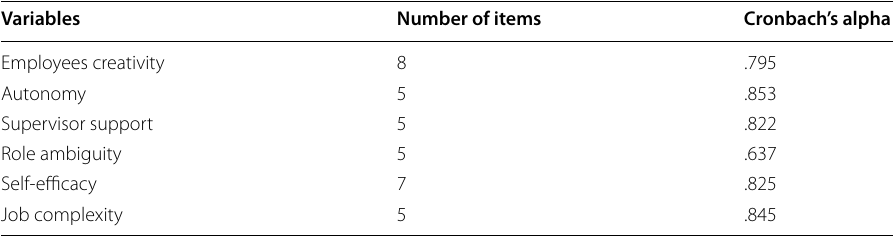
Table 2 Reliability of the study variables. Source: own survey (2020)